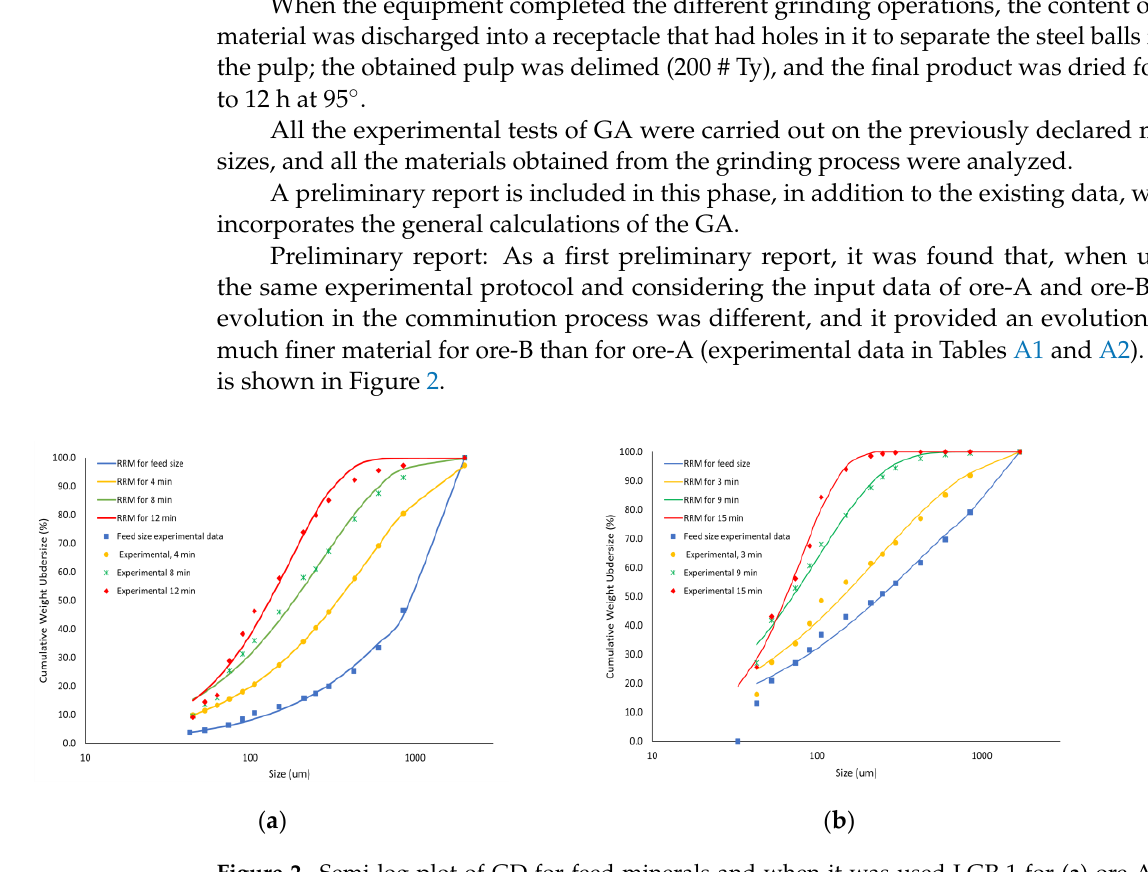
Figure 2. Semi-log plot of GD for feed minerals and when it was used LGP-1 for ( a ) ore-A and ( b ) ore-B.